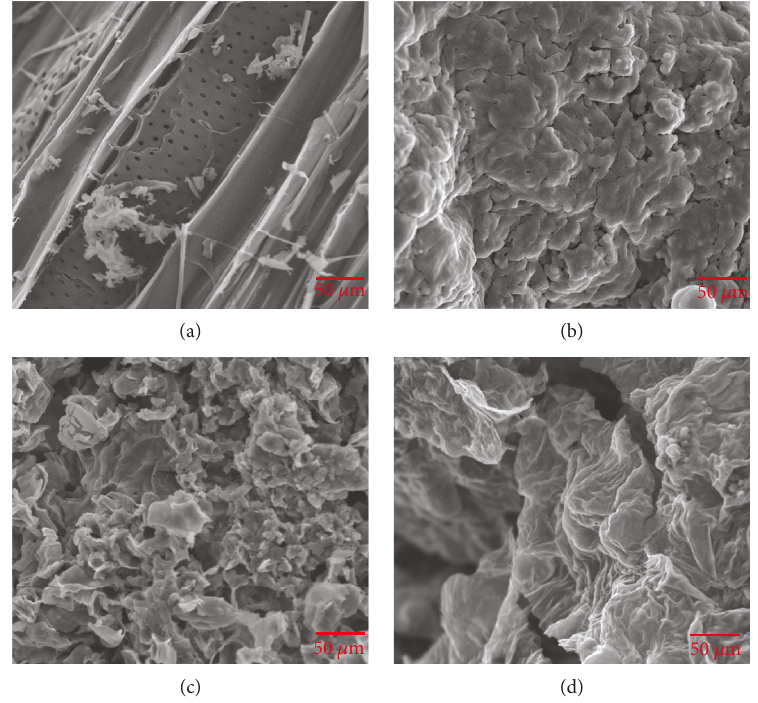
Figure 19: SEM of (a) Control IFR, (b) ZBS2%, (c) ZBM2%, and (d)